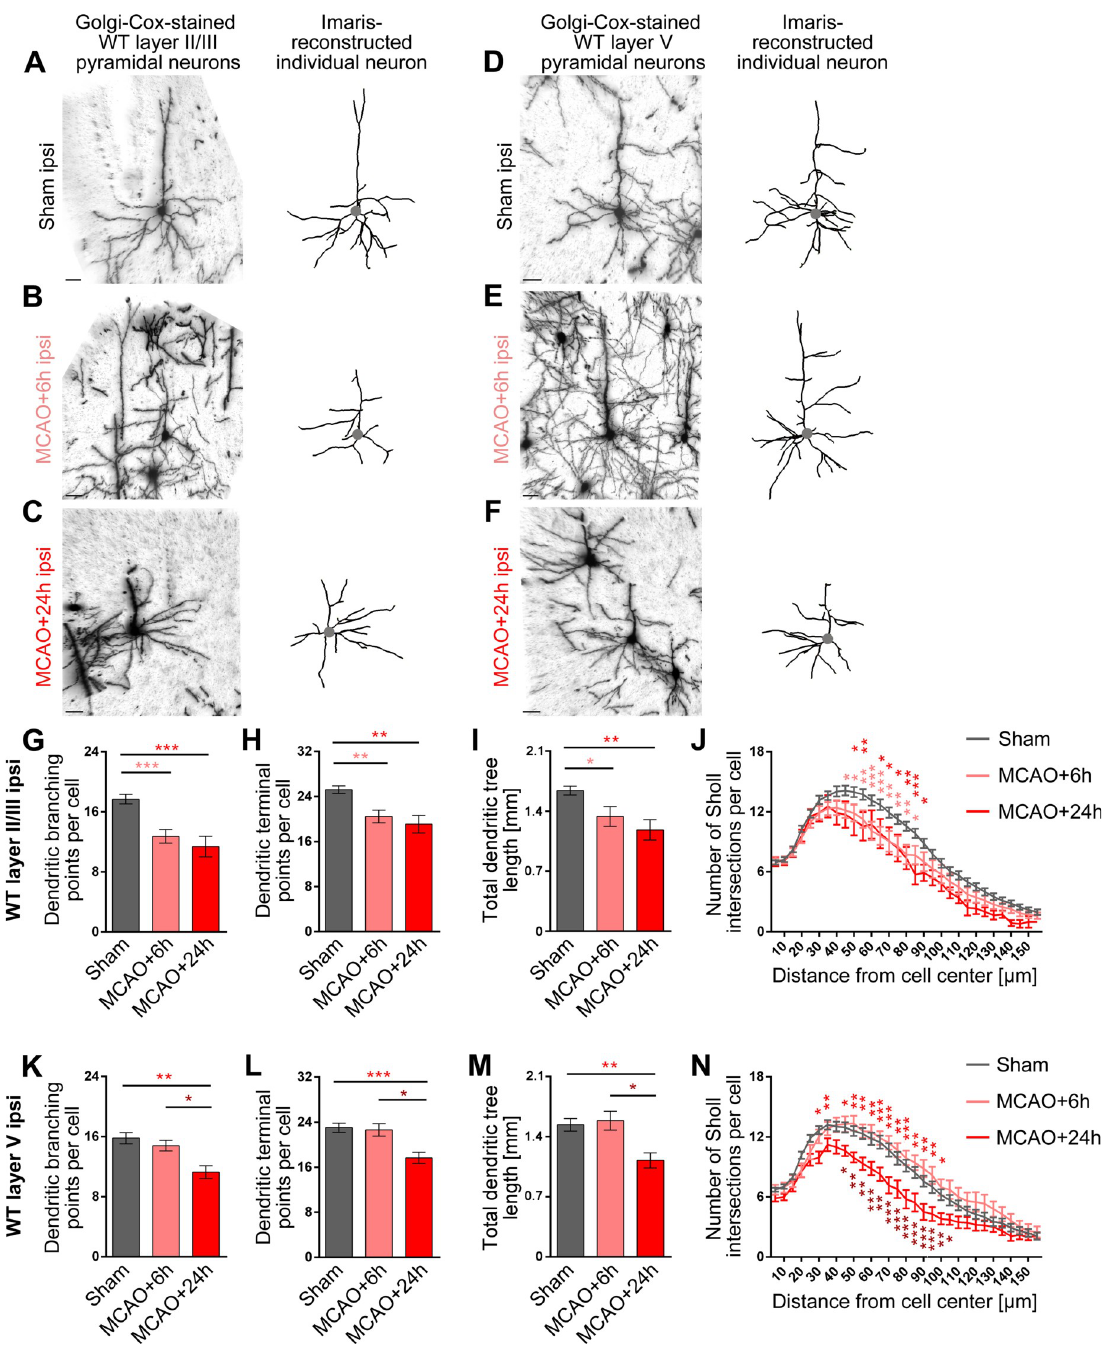
Fig 4. Loss of dendritic arbor complexity subsequent to ischemic stroke in ipsilateral layer II/III and layer V neurons of the motor cortex. A–F , Representative images of Golgi–Cox-stained (left panels) and individual Imaris-reconstructed (right panels) layer II/III ( A– C ) and layer V ( D–F ) pyramidal neurons of M1 from the ipsilateral side of sham-treated control mice ( A, D ) and of mice subjected to 30-minute MCAO analyzed after 6 hours ( B, E ) and 24 hours ( C, F ) reperfusion times. The position of the cell bodies are marked by a gray dot. Scale bars, 30 μ m. G–N , Quantitative determinations of dendritic branching points, terminal points, total dendritic tree length, and Sholl intersections of dendritic trees in layer II/III ( G–J ) and layer V ( K–N ). Note that all parameters of dendritic complexity at the ipsilateral side decreased subsequent to MCAO and that layer II/III neurons responded faster, as they already show the decreased dendritic arborization at 6 hours after MCAO (for contralateral data, see S3 Fig ). Layer II/III: n Sham = 60; n MCAO+6h = 22; n MCAO+24h = 11 neurons. Layer V: n Sham = 47; n MCAO+6h = 19; n MCAO+24h = 18 neurons from 3 mice for each MCAO group and 6 mice for the sham control (ipsi). Quantitative data represent mean ± SEM. Statistical significance calculations, 1-way ANOVA with Tukey posttest ( G–I, K–M ) and 2-way